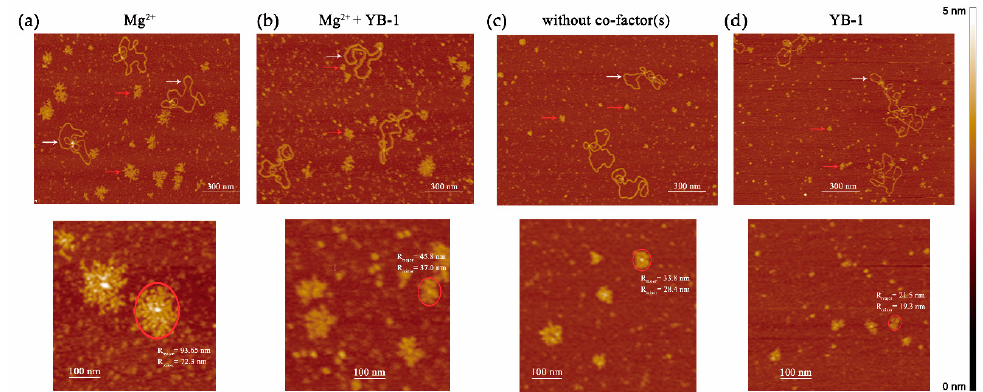
Figure 8. Atomic force microscopy (AFM) images of PARylated PARP1 in the presence of different co-factors. The images illustrate auto-PARylation of PARP1 in the presence of Mg 2+ ( a ), in the presence of Mg 2+ and YB-1 ( b ), without co-factors ( c ), or in the presence of YB-1 ( d ). Upper panel: AFM images of PARylated PARP1. White arrows indicate plasmid DNA molecules, and red arrows point to PARylated proteins. Scale bar: 300 nm; Z scale: 5 nm. Lower panel: zoomed-in images of PARylated PARP1. The two radii of the ellipse enclosing PARylated PARP1 were used to estimate the area of a modified protein molecule. Scale bar: 116 nm; Z scale: 5 nm. When PARP1 was incubated with DNA in the presence of NAD + , the formation of PAR polymers was detectable by AFM in all reaction systems (Figure 8). The sizes of the PARylated PARP1 molecules were estimated by means of the AFM images obtained for four reaction systems: with Mg 2+ , YB-1, both, or without them (Figure 9).